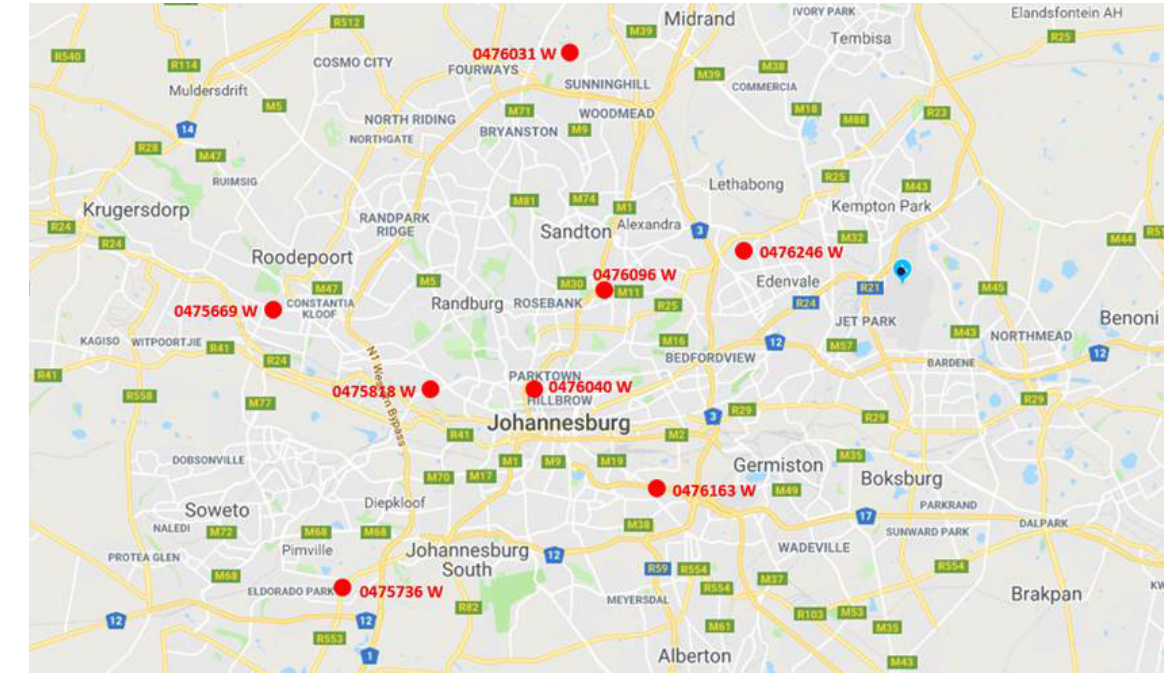
Figure 1. Location of rainfall stations.